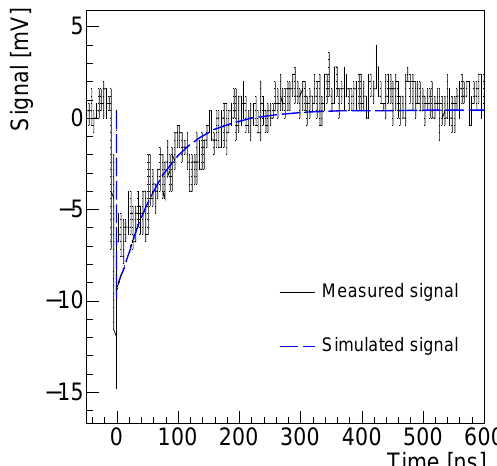
Figure 5. Simulated (blue dotted line) and measured (dark continuous line) signal of the SiPM prototype in response to a detected optical photon or a thermally generated electron/hole pair.